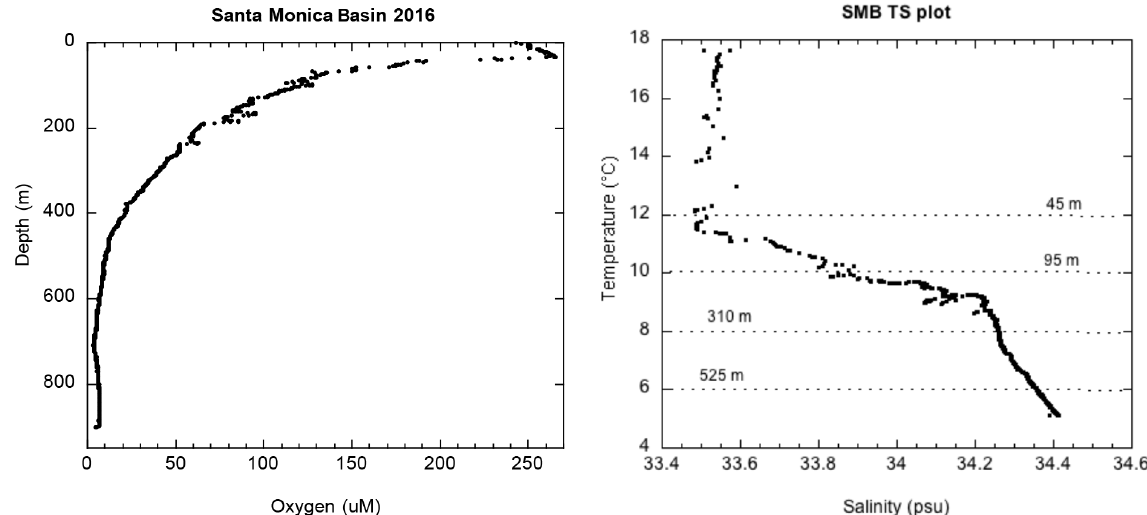
Figure 2. Water column oxygen and TS plot for SMB obtained in spring